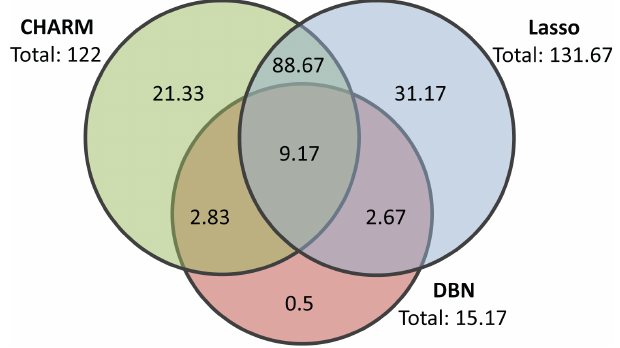
Figure 7. Number of relationships found in network, averaged across coupling